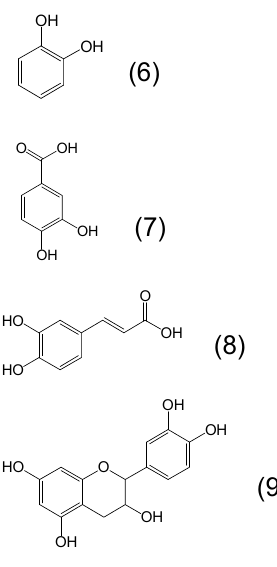
Figure 3. Examples of phytochelators with the chemical structure containing catechol as the metal binding site moiety. Catechol or benzene-1,2-diol ( 6 ), protocatechuic acid or 3,4-dihydroxybenzoic acid ( 7 ), caffeic acid or 3-(3,4-dihydroxyphenyl)-2-propenoic acid ( 8 ) and catechin or 2-(3,4-dihydroxyphenyl)-3,4-dihydro-2 H -chromene-3,5,7-triol ( 9 ).